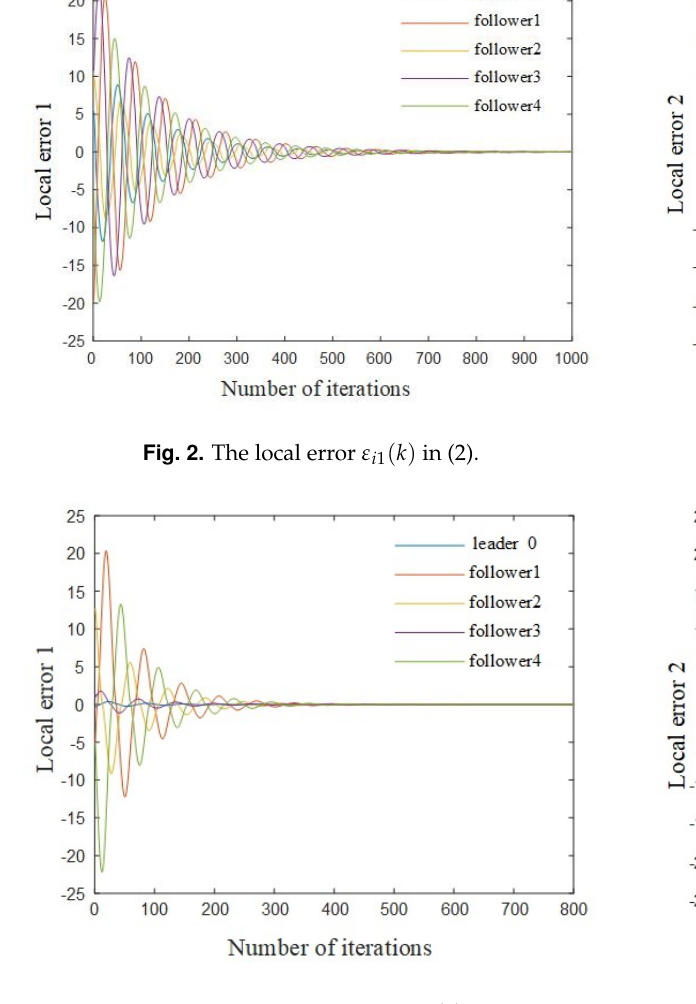
Fig. 5. The finite time local error ε i 2 ( k ) in